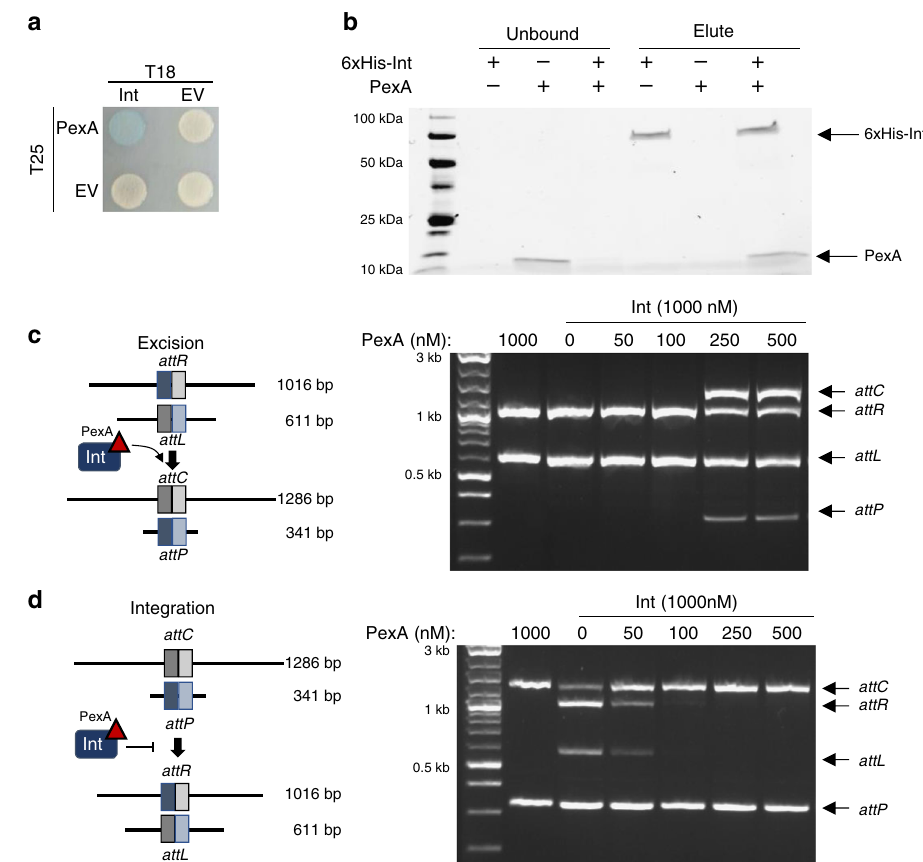
Fig. 4 PLE exploits phage encoded PexA as the RDF for excision. a Bacterial two hybrid analysis to detect protein – protein interactions. Cells containing fusions of PexA to the T25 subunit of adenylate cyclase CyaA (indicated on left) and Int to the T18 subunit (indicated on top) were spotted on X-gal. Blue colonies indicate a physical interaction between the proteins fused to the CyaA subunits. b Puri fi ed 6xHisSUMO-Int (1 mM) and/or PexA (0.25 mM) were incubated for 30 min and then incubated with nickel resin. Unbound and eluted fractions were collected and were run on an SDS-PAGE gel. c Left, cartoon of in vitro excision reaction shows dsDNA fragments containing attL and attR recombining to attC and attP in the presence of Int and PexA. Right, in vitro excision assay shows when puri fi ed PexA or Int are incubated alone with attL and attR (lanes 1 and 2, respectively), no recombination is detected. As the concentration of PexA increases, recombination products attC and attP are detected. d Left, cartoon of in vitro integration reaction depicting the ability of PexA to inhibit the activity of Int when recombining attC and attP sites in an integration reaction. Right, in vitro inhibition of integration (right) by PexA can be seen by the loss of the attL and attR recombination products as puri fi ed PexA increases in concentration. Uncropped gels are presented